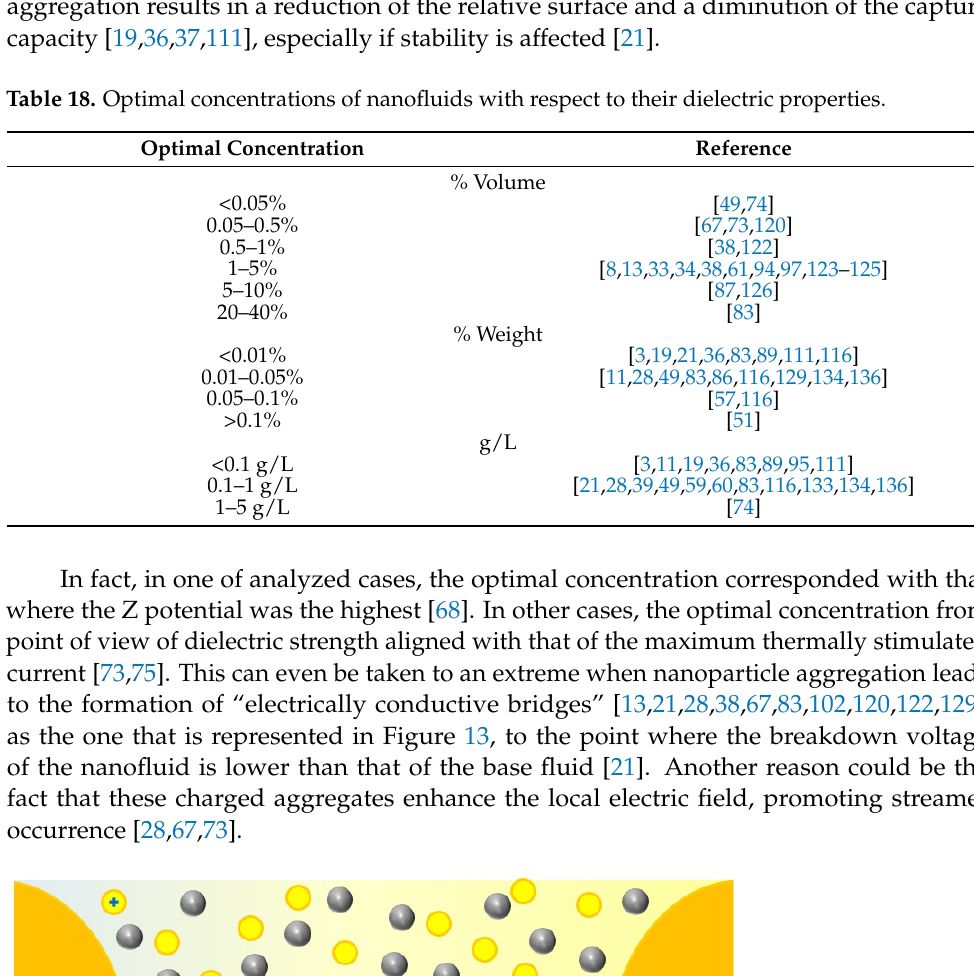
Table 18. Optimal concentrations of nanofluids with respect to their dielectric properties.